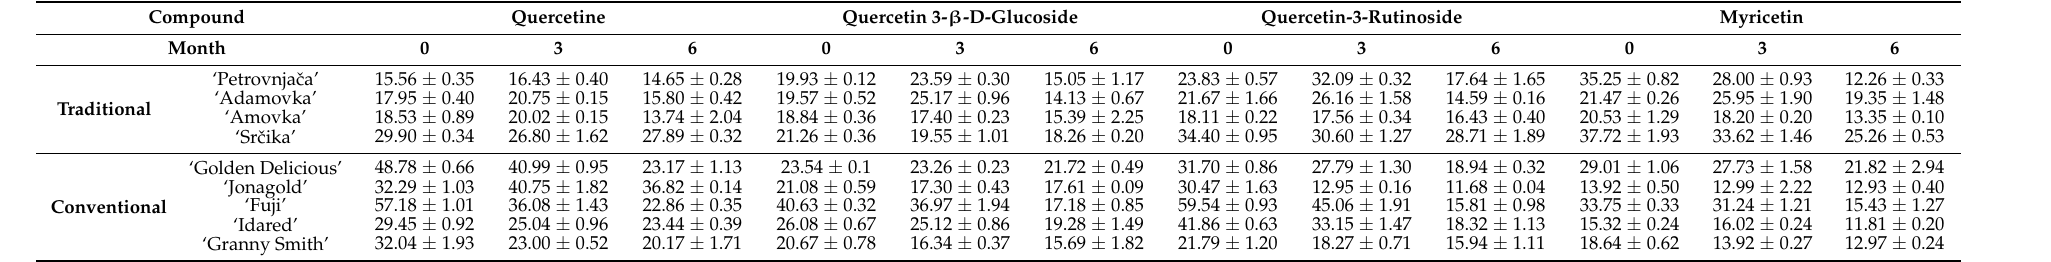
a : Dry weight. Mean ± SD based on two extracts each measured twice ( n = 4). Table 5. The content of flavonols ( µ g/g dw a ) in the traditional and conventional apple cultivars.